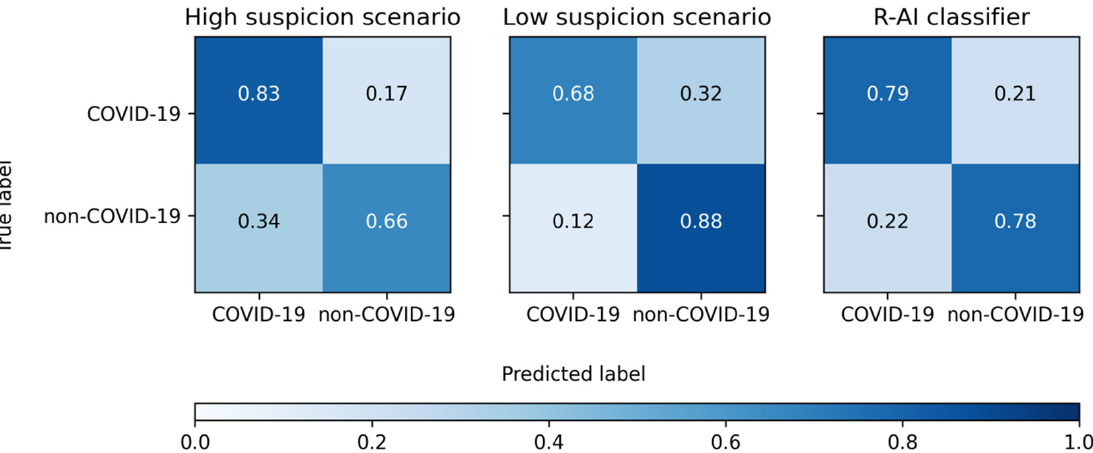
Figure 2. Confusion matrices of the global performance of the four readers in the high and low suspicion scenarios and the radiomic-based artificial intelligence (R-AI) classifier in distinguishing COVID-19 from other types of viral pneumonia.